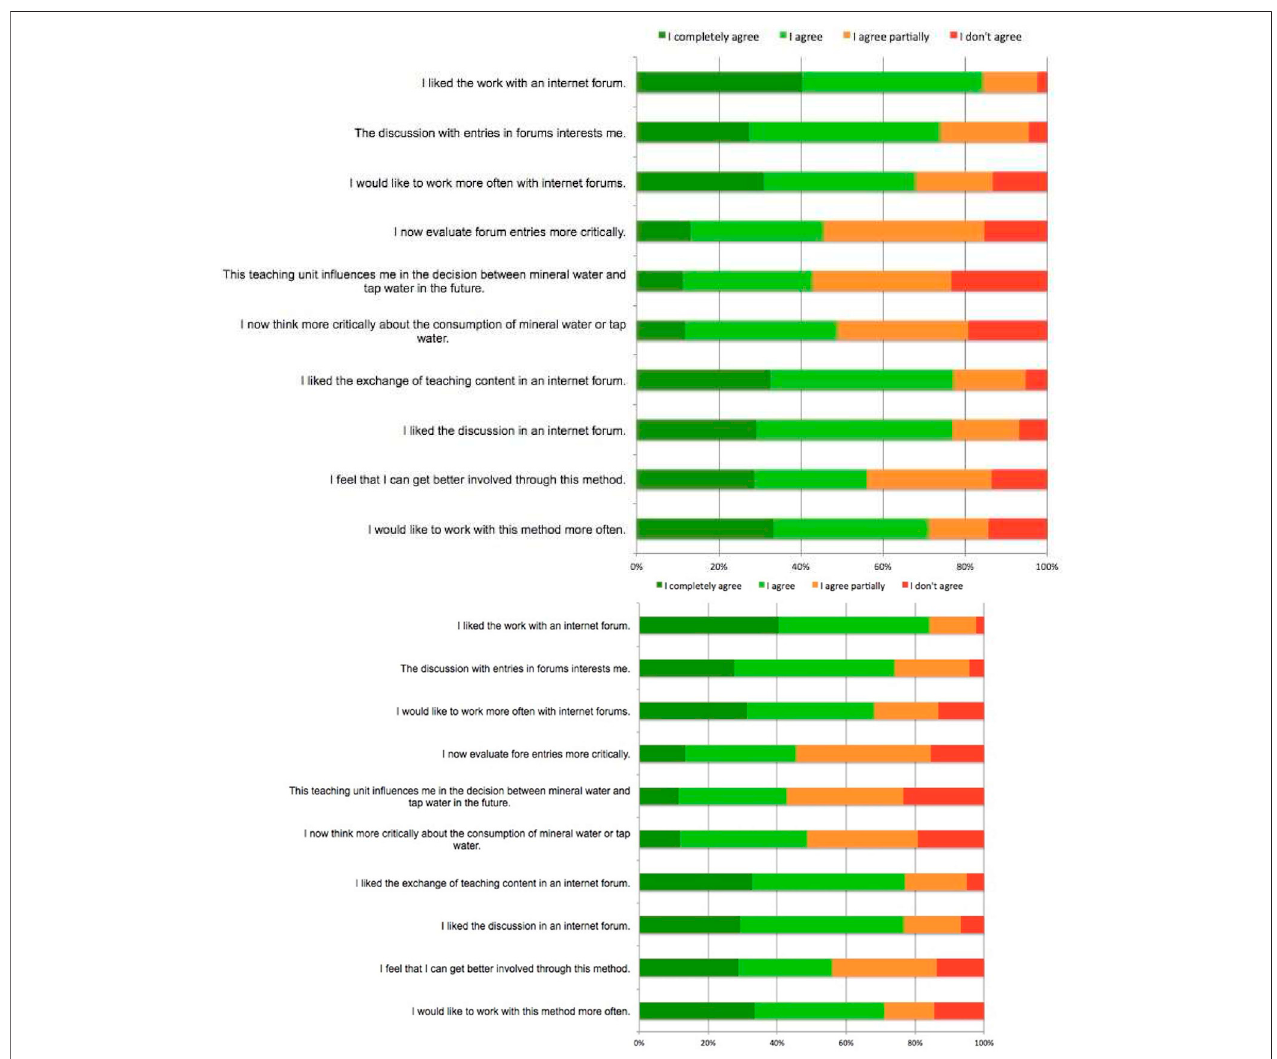
FIGURE 2 | Results from the Likert questionnaire (N (cid:1)